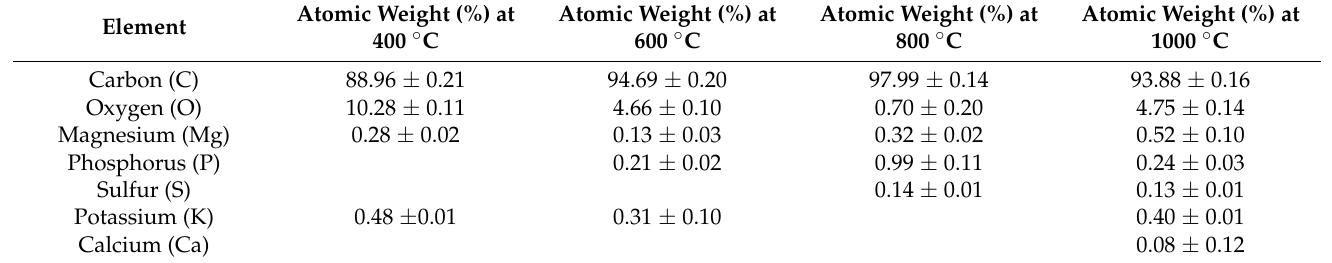
Table 2. Elemental composition of date palm seeds valorized at different temperatures.